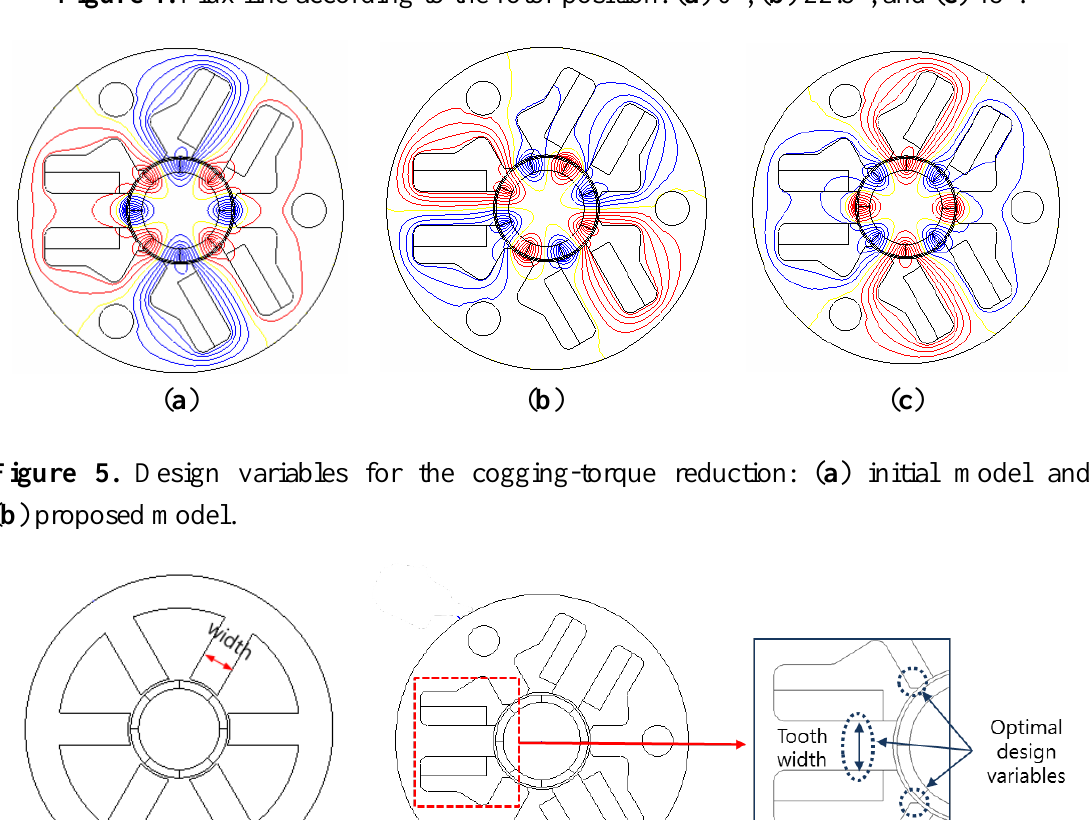
Figure 4. Flux line according to the rotor position: ( a ) 0°, ( b ) 22.5°, and ( c ) 45°.